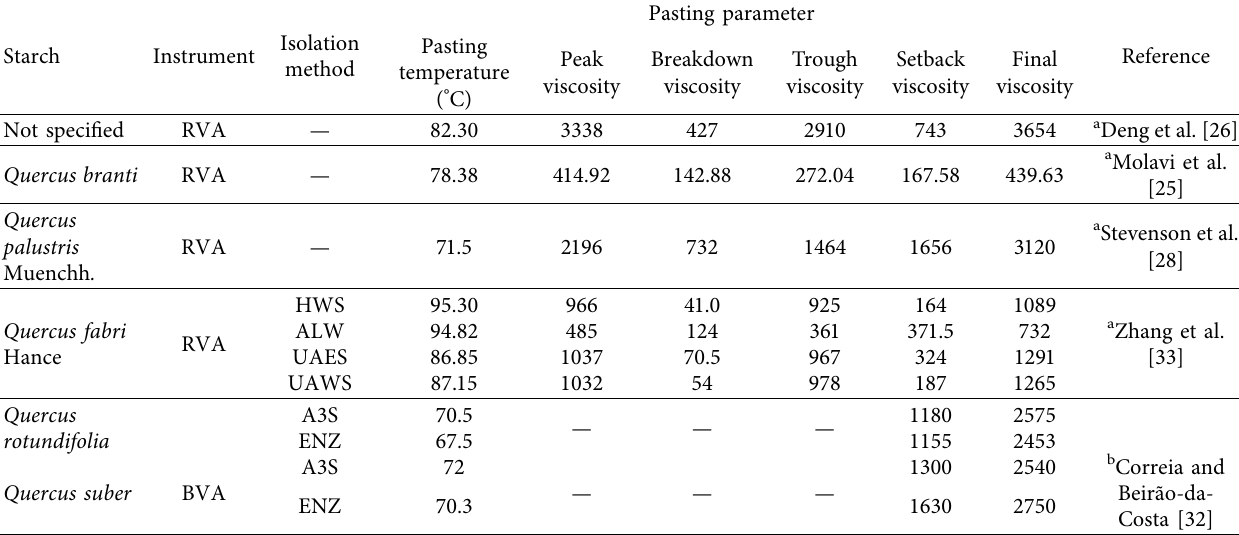
Table 4: Pasting properties of acorn